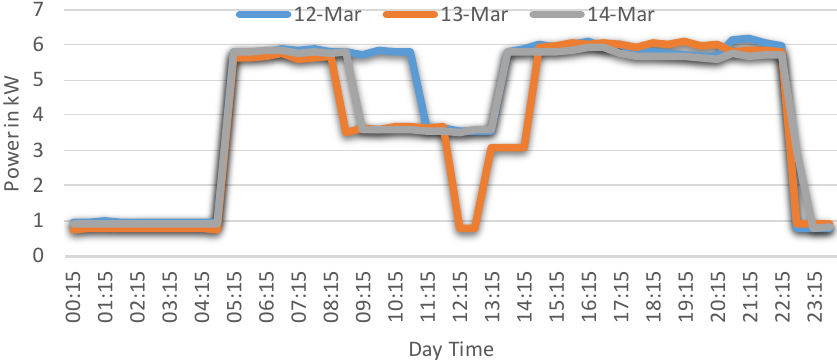
Figure 4. Daily power consumption in the monitored classroom.